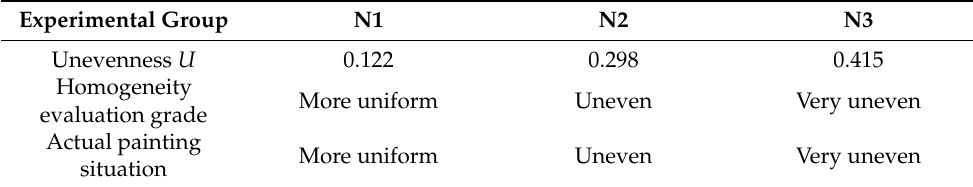
Table 6. Evaluation results of concrete coating uniformity in each experimental group. Experimental Group